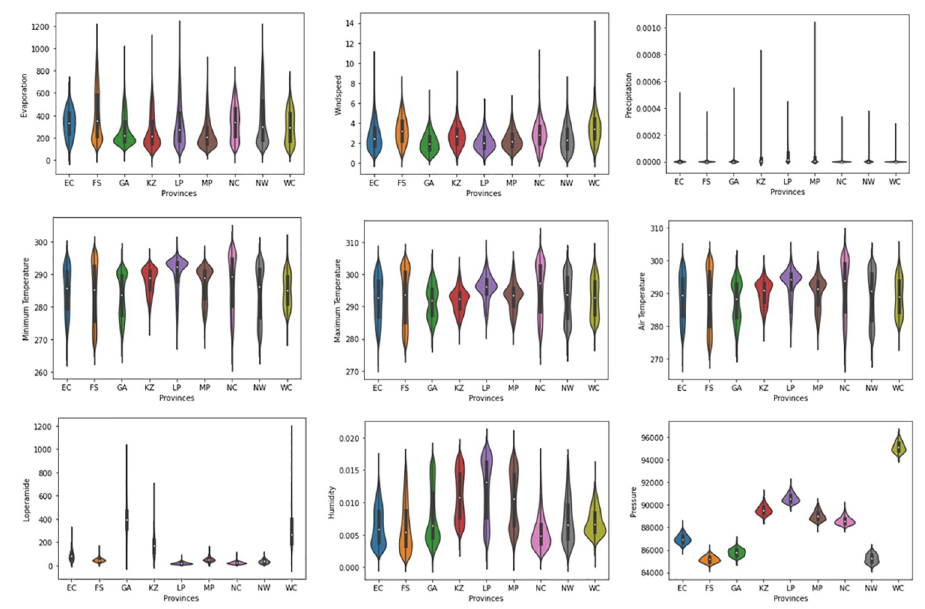
Fig 1. Violin plots showing the distribution of loperamide (diarrhoea) and climate variables across the provinces. EC = Eastern Cape, FS = Free State, GA = Gauteng, KZ = KwaZulu Natal, LP = Limpopo, MP = Mpumalanga, NC = Northern Cape, NW = North West, WC = Western Cape. The distribution of the real-world and synthetic data (augmented data) are shown in S1 and S2 Figs